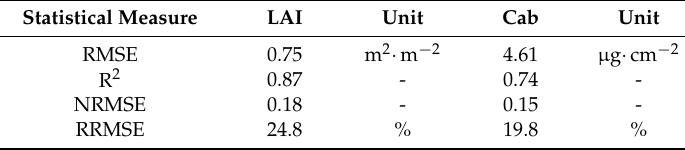
Table 5. Evaluation of RTMo model inversion results for LAI ( n = 8) and Cab ( n = 108)